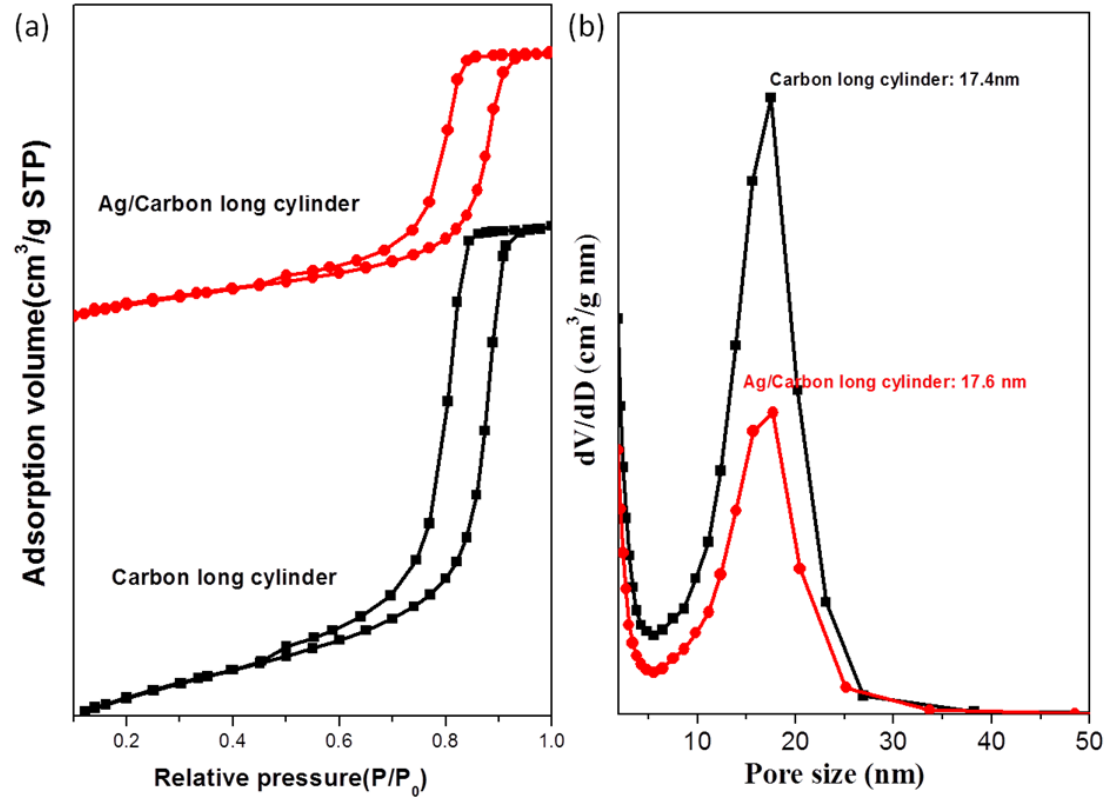
Figure 3. ( a ) N adsorption/desorption isotherms and ( b ) pore size distribution curves of 2 the hexagonal cylindrical mesoporous carbon and the Ag/cylindrical